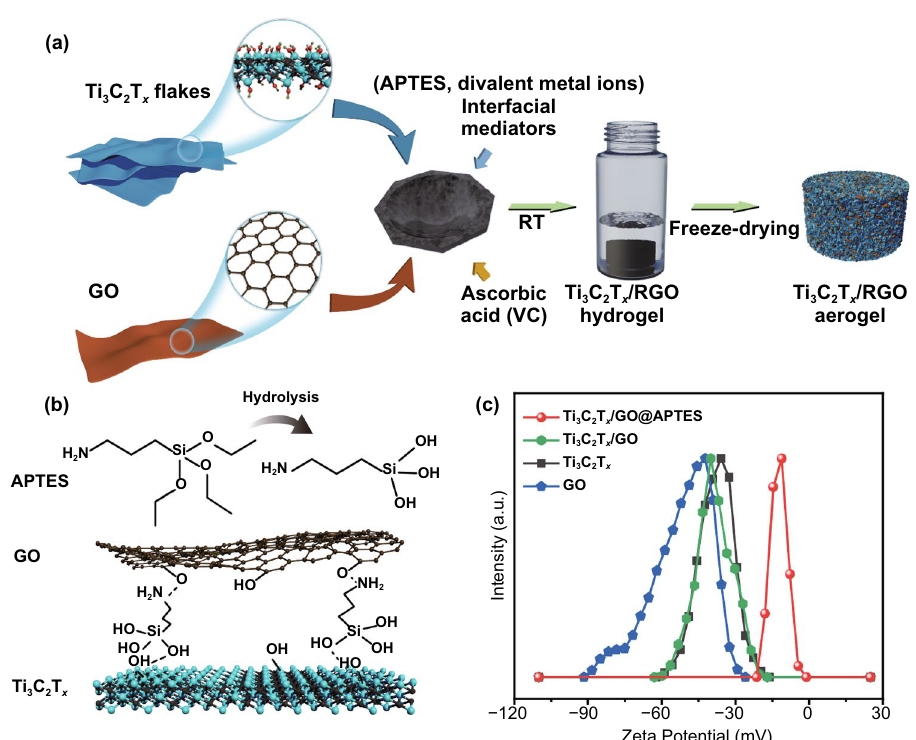
Fig. 1 a Schematic illustration of the synthetic process of Ti 3 C 2 T x /RGO aerogels. b Diagram of the cross-linking of Ti 3 C 2 T x and RGO nanosheets by the hydrolyzed APTES. c Zeta potentials of Ti 3 C 2 T x , GO, Ti 3 C 2 T x /GO, and Ti 3 C 2 T x /GO with the addition of